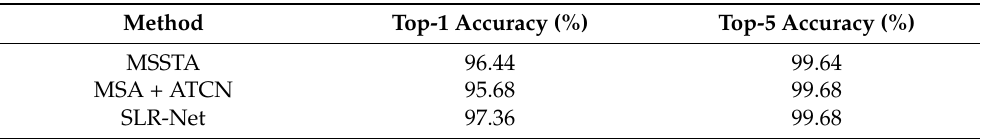
Table 5. The experiment of dual-path feature extraction network, MSSTA is the one path of SLR-Net and MSA + ATCN is another path. Tested on CSL-500 dataset.